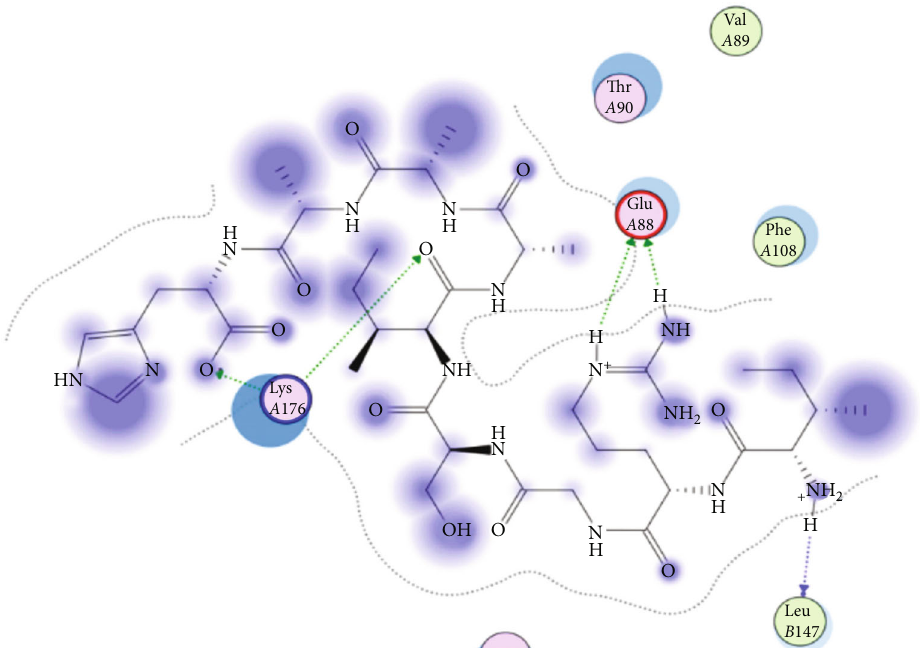
Figure 20: Illustration of the 3D interaction of the best docking poses of IRGSIAAAH in the binding sites of HLA-DRB1 ∗ 01:01.